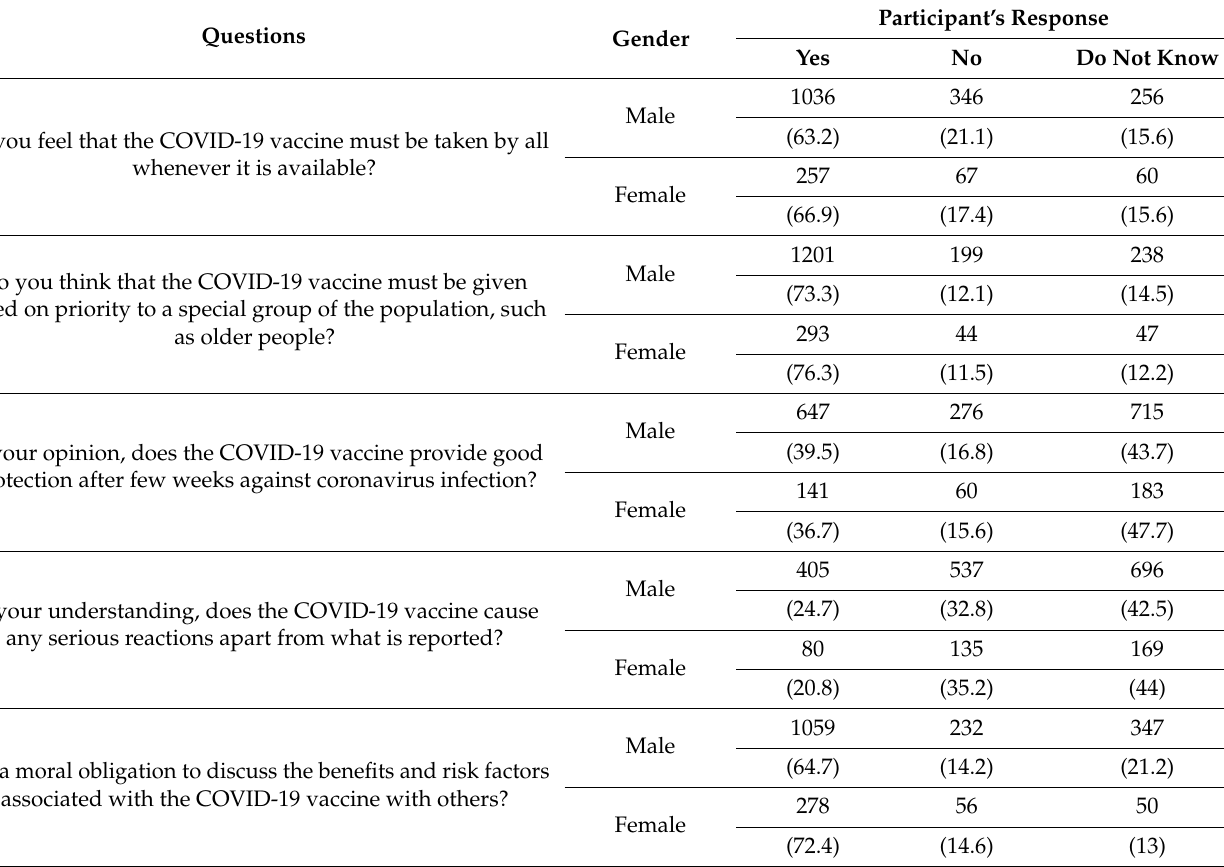
Table 3. Frequency of response for the attitude questions by the